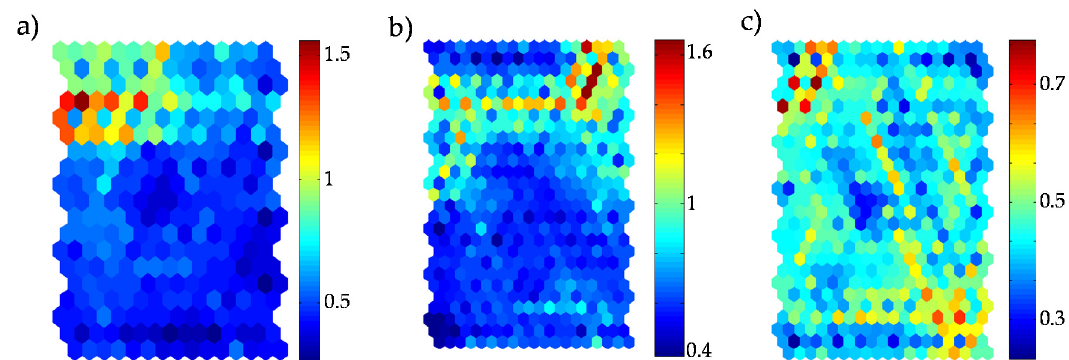
Figure A1. The process of SOM recognition. The SOM training results ( a ); individual (D0516) was recognized as having no cluster change ( b ); while individual (B0209) was recognized as having undergone a cluster change from cluster III to I ( c ).